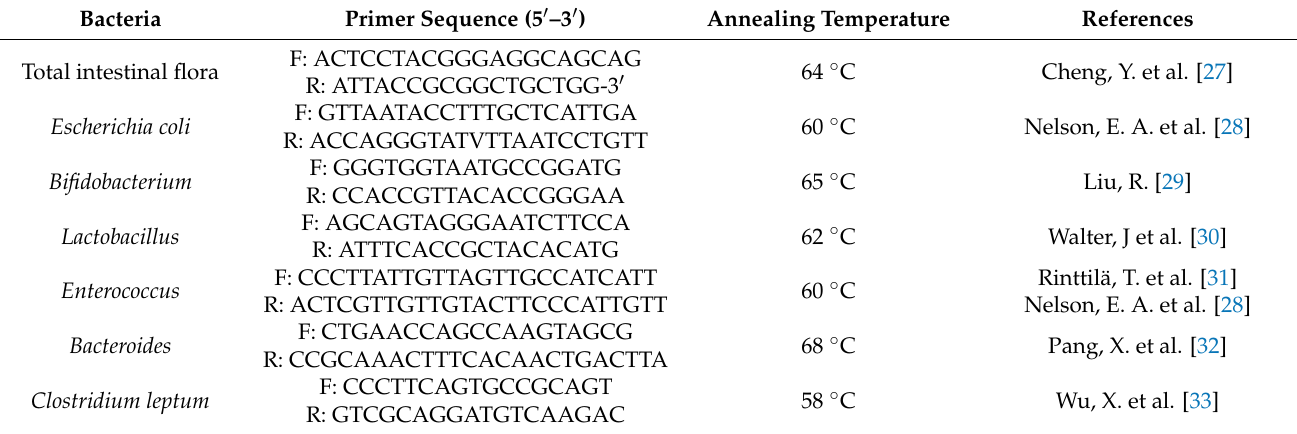
Table 2. Primer sequences of 7